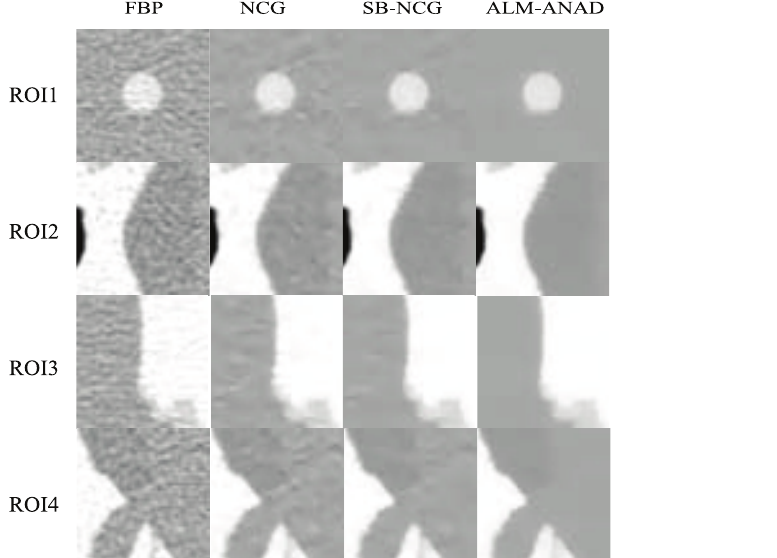
Fig 4. Zoomed details of the four ROIs in Fig 2.